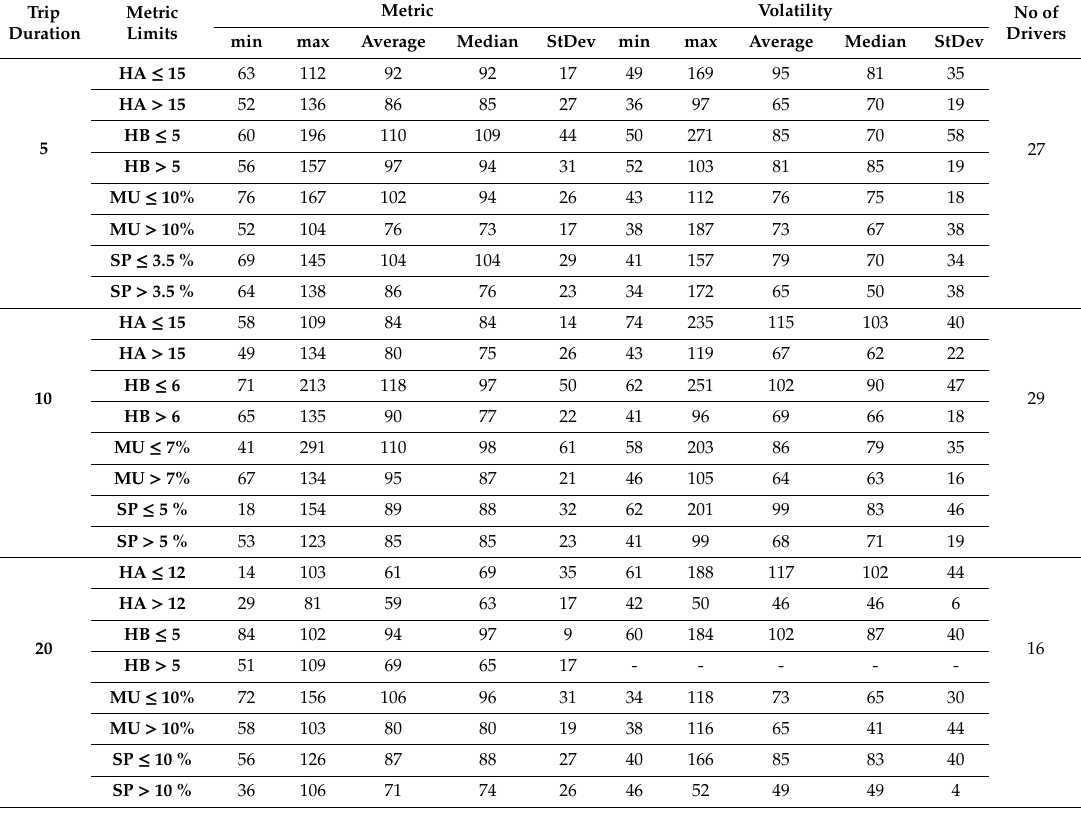
Table 1. Aggregated table of minimum number of trips required for